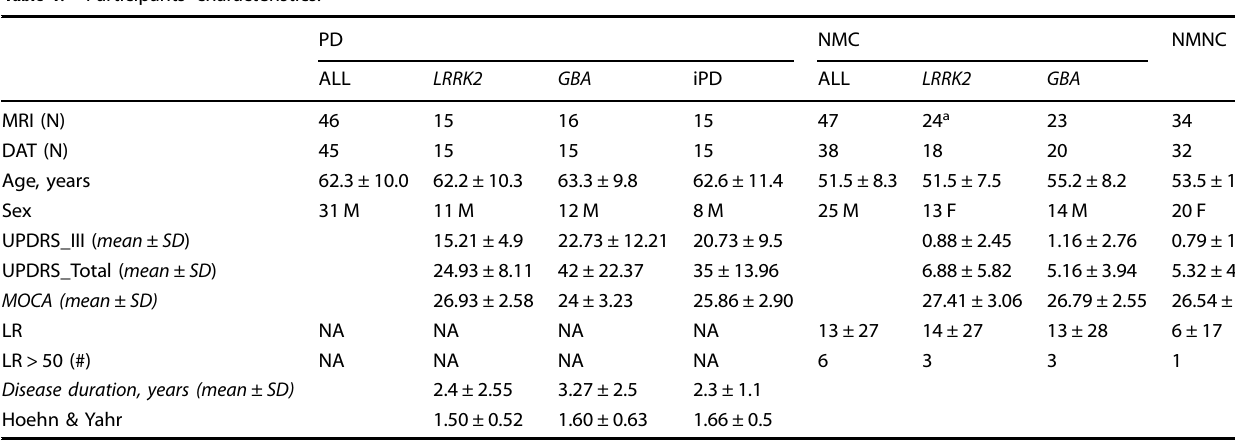
Table 1. Participants ’ characteristics.